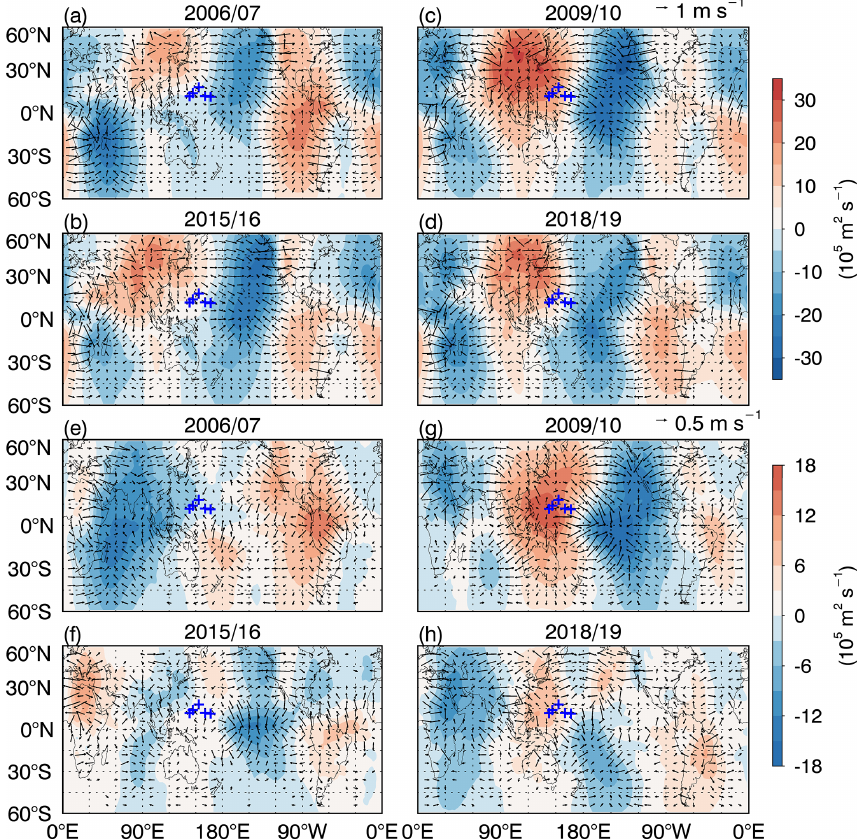
Figure 8. Velocity potential (shading) and divergent (arrow) wind of monsoon circulation and their anomalies at 850hPa in (a, e) 2006/07, (b, f) 2015/16, (c, g) 2009/10 and (d, h) 2018/19 winters. Panels (a–d) denote the velocity potential and divergent wind, and (e) – (h) denote their anomalies. The blue plus denotes the five radiosonde stations.